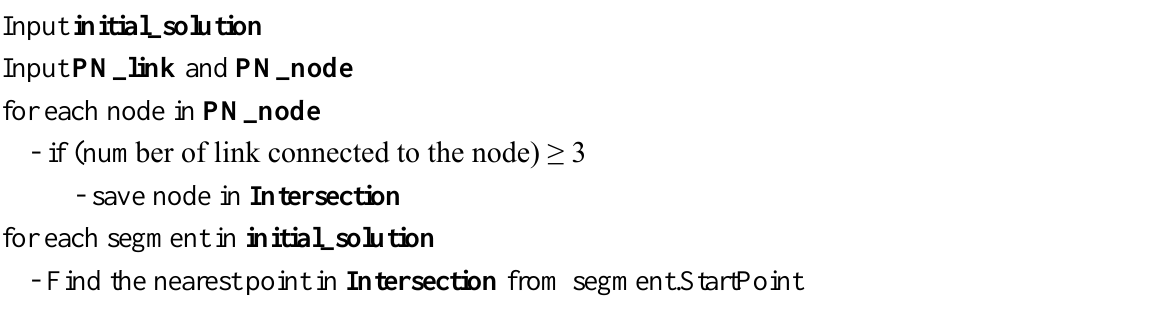
Algorithm 2 Correcting errors near the intersections